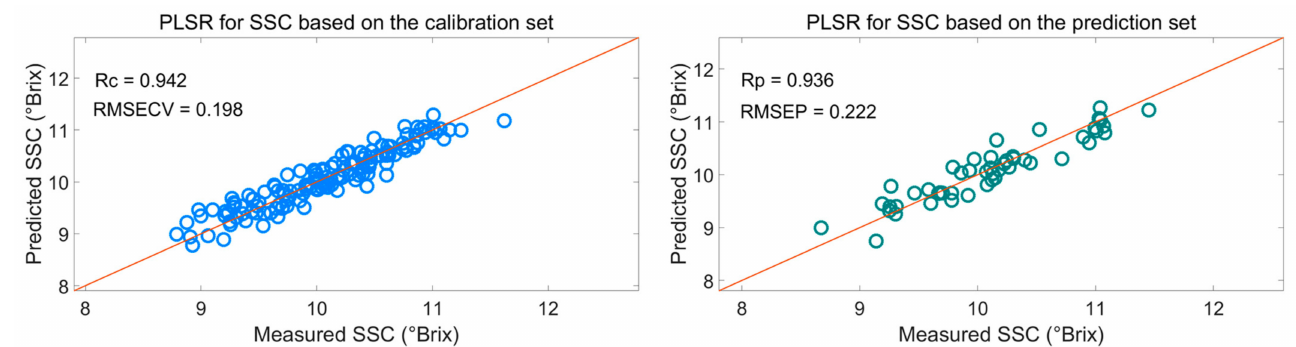
Figure 8. PLSR model for SSC based on the useful wavelengths selected by SiPLS-VSCAA. Rc: correlation coefficient of calibration; RMSECV: root mean square error of cross validation; Rp: correlation coefficient of prediction; RMSEP: root mean square error of prediction.